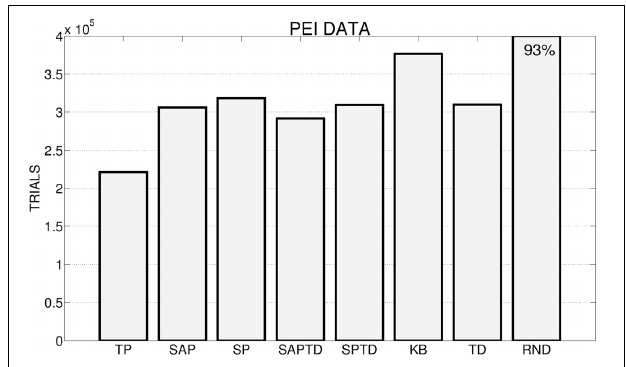
FIGURE 9 | Average number of trials needed by the system to achieve an average performance of 95% in the 4 learnable tasks (average results of 180 replications: 20 replications by 9 learning rates for the systems with predictors, and 180 replications for the RND ad TD conditions) in the different experimental conditions. If a system has not reached 95% we report on the corresponding bar the average performance at the end of the